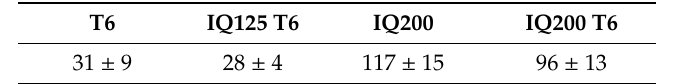
Table 3. Width of the precipitation-free zone, d PFZ